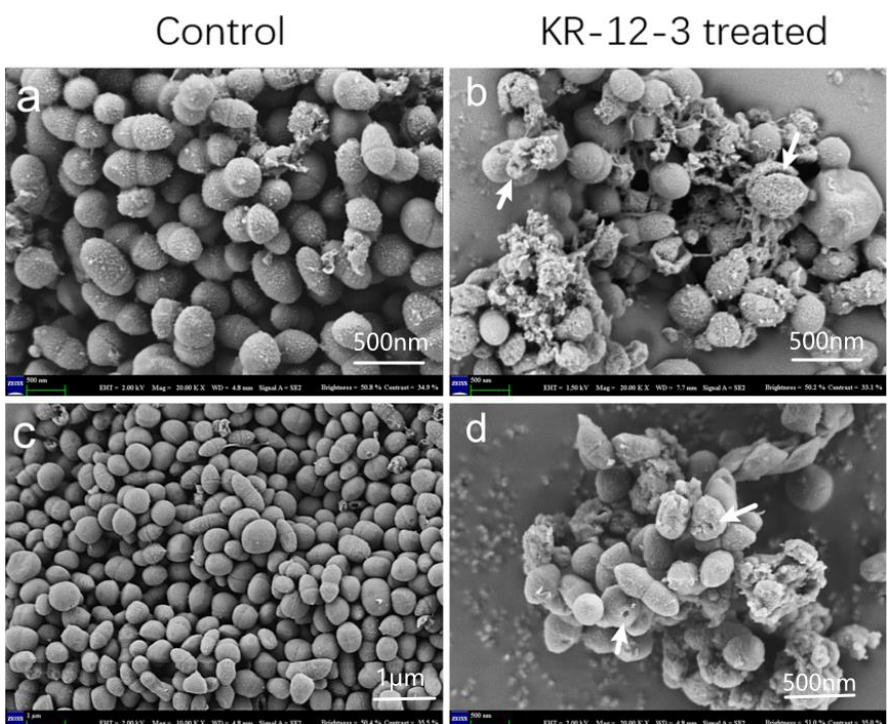
Figure 3. The control group, which lacks peptide treatment, was cultured for 4 h, as shown in ( a ) and ( c ). ( b ) and ( d ) were SEM micrographs of S. gordonii cells treated with peptide at 1× MICs for 4 h. As indicated by the white arrows, significant cell wall distortion, corrugation, and damage were observed on the surface of S. gordonii cells after treatment with the peptide compared with the smooth surface of the control. The experiments were all repeated at least 3 times.